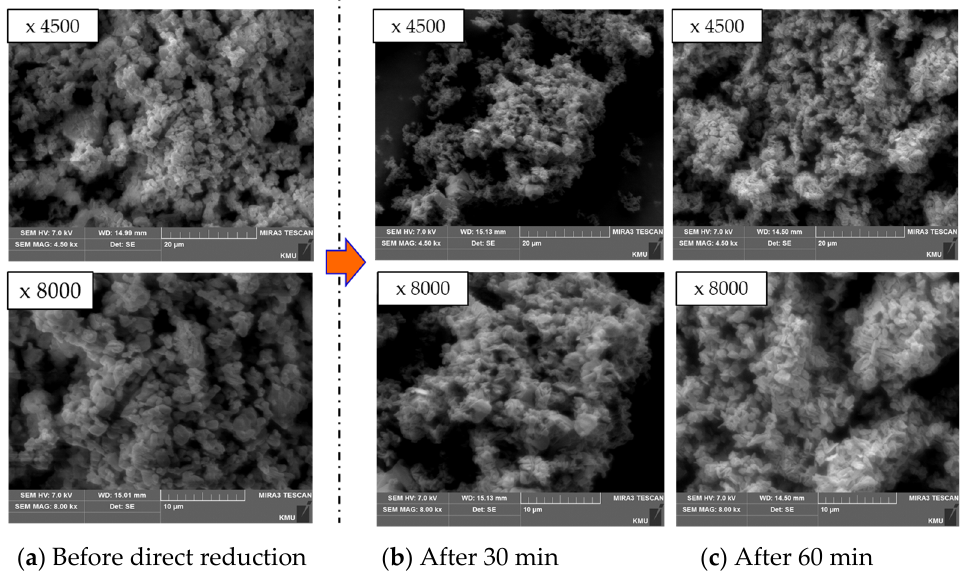
Figure 10. SEM images of the (NH 4 ) 4 Mo 5 O 17 before and after the direct hydrogen reduction at 575 °C.